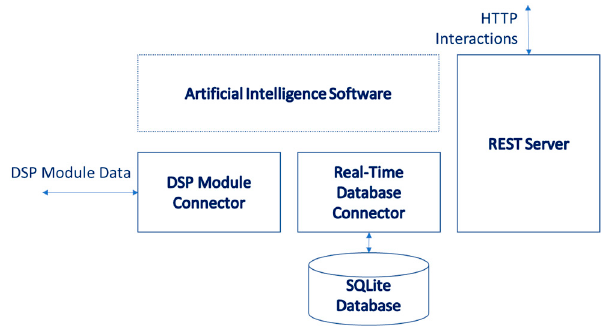
Figure 7. High-level architecture of the edge processing module